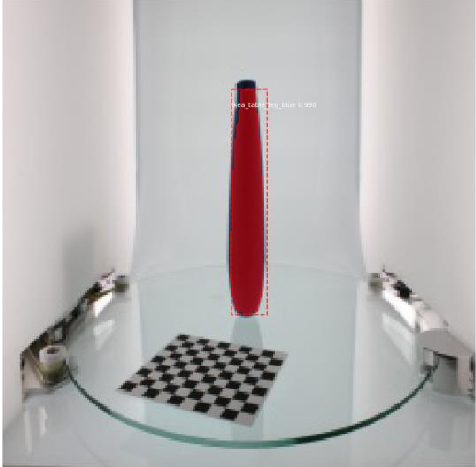
Figure 6. Object detection results using the Mask R-CNN